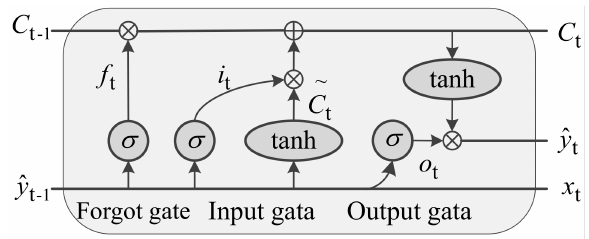
Figure 4. Structure of